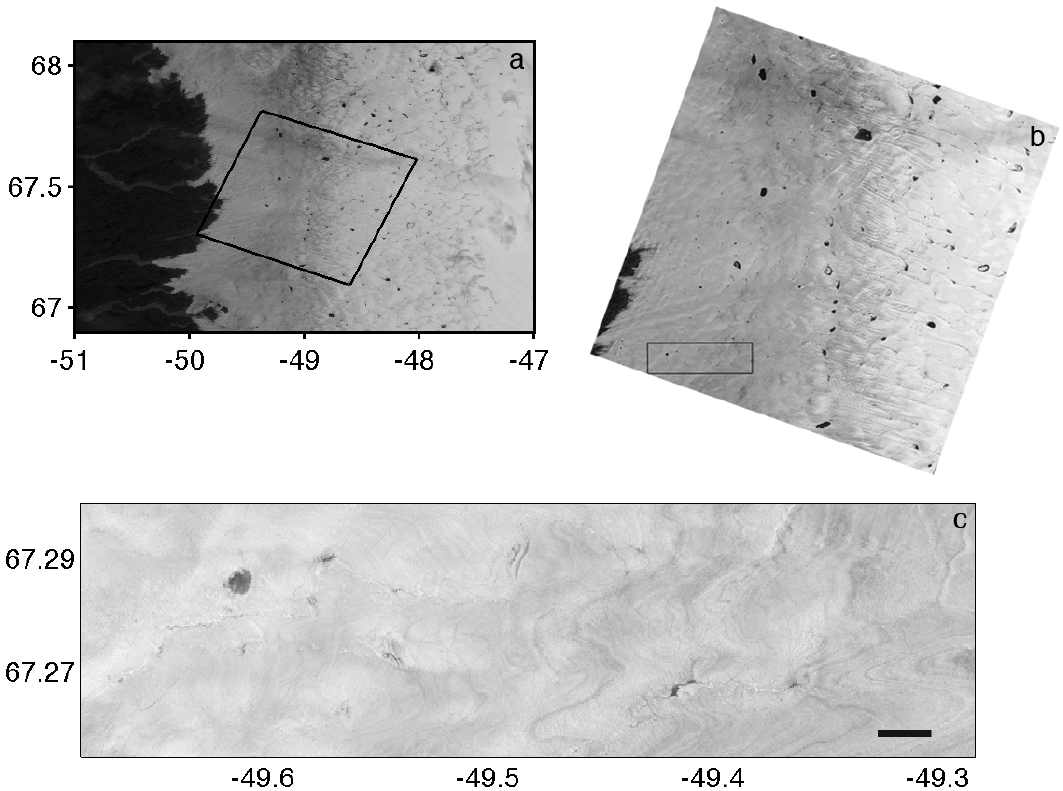
Fig. 8. ASTER and MODIS images of 2 August 2004. Panel (a) shows a part of the MODIS image of 2 August 2004 with the black contour indicating the area of the ASTER image. Panel (b) shows the complete ASTER image and panel (c) the inset of panel (b), showing the transition from the brighter ice to the darker ice. The scale bar in the lower right corner of panel (c) is approximately